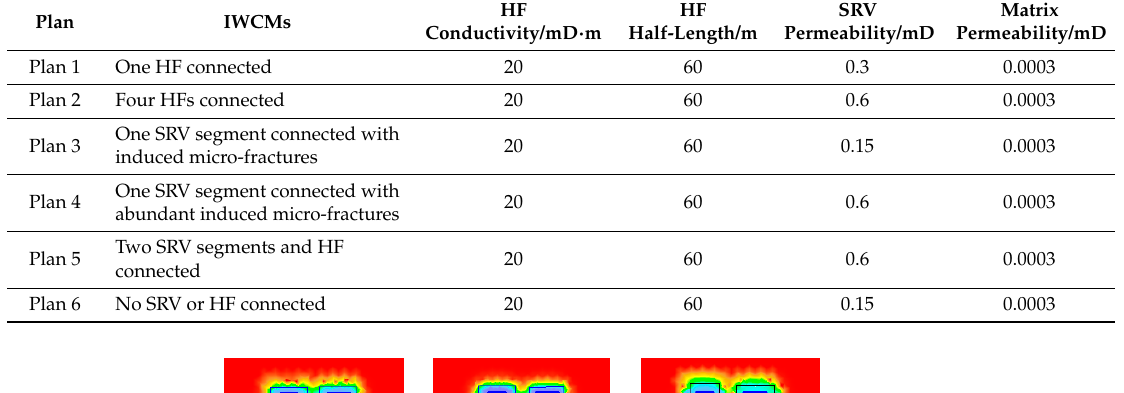
Table 1. Inter-well communication modes (IWCMs) and essential physical properties of each plan.